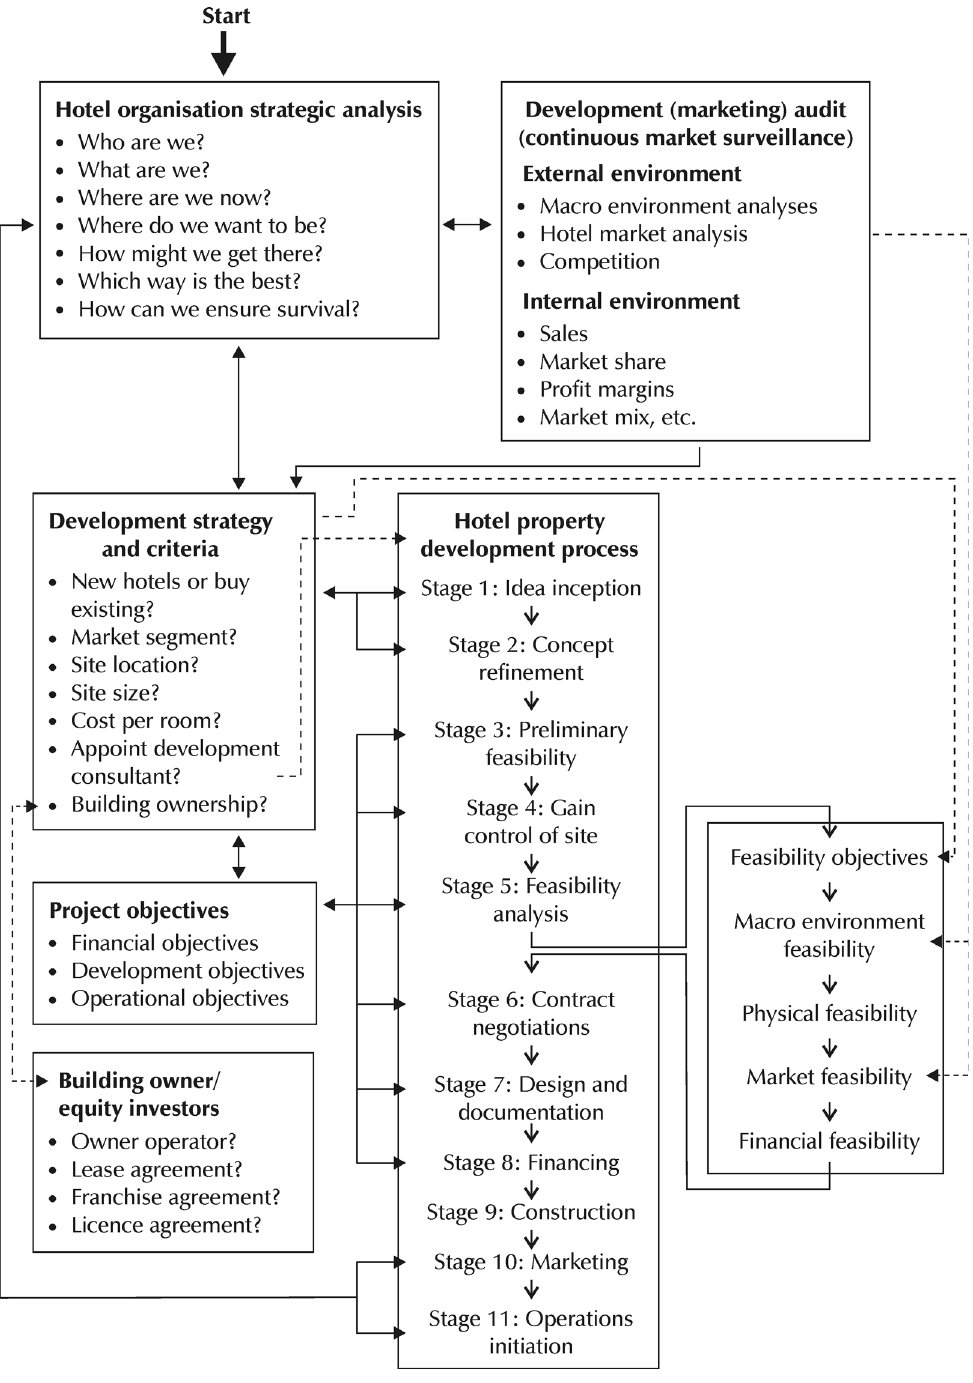
(Source: Culmination of views in the literature review) Illustration 3(a) Hotel development framework for a hotel